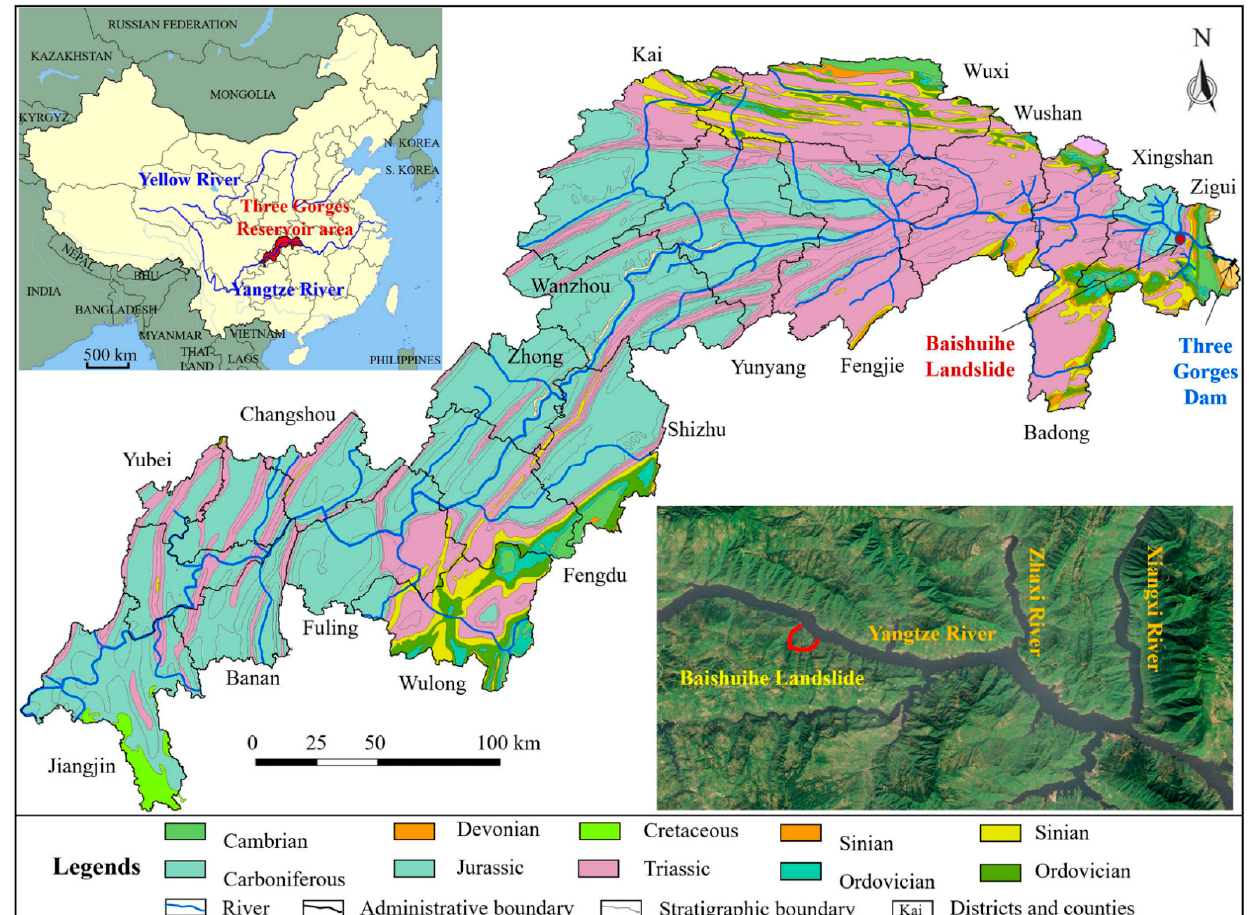
Figure 4. Geological map of the Three Gorges Reservoir